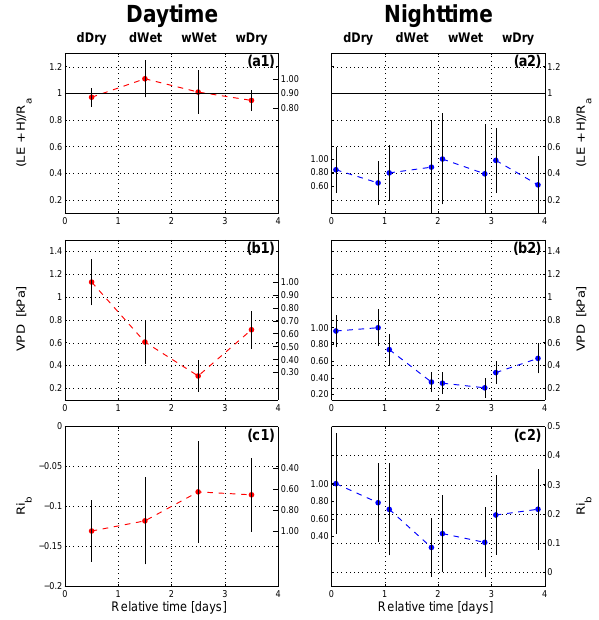
Figure 13. As in Fig. 10, showing (a1, a2) the surface energy bal- ance closure fraction (LE + H ) /R a ; (b1, b2) vapor pressure deficit VPD; and (c1, c2) bulk Richardson number Ri b